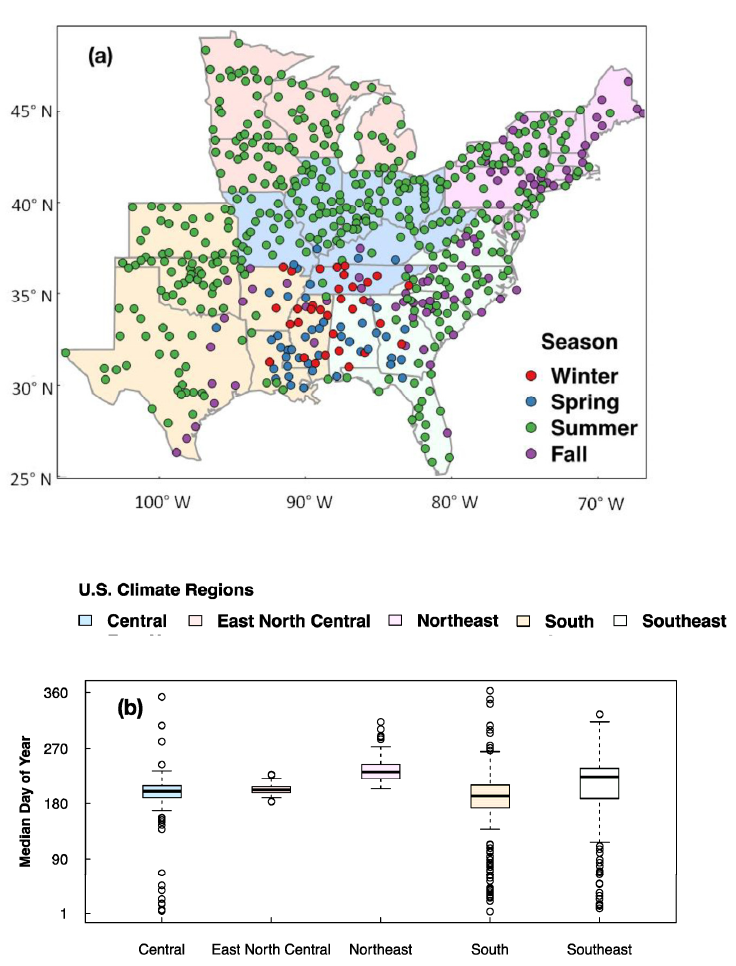
Figure 3. ( a ) Spatial patterns of median day of year of annual maximum daily precipitation during the study period of 1950–2019. ( b ) Regional distribution of median day of year of annual maximum daily.